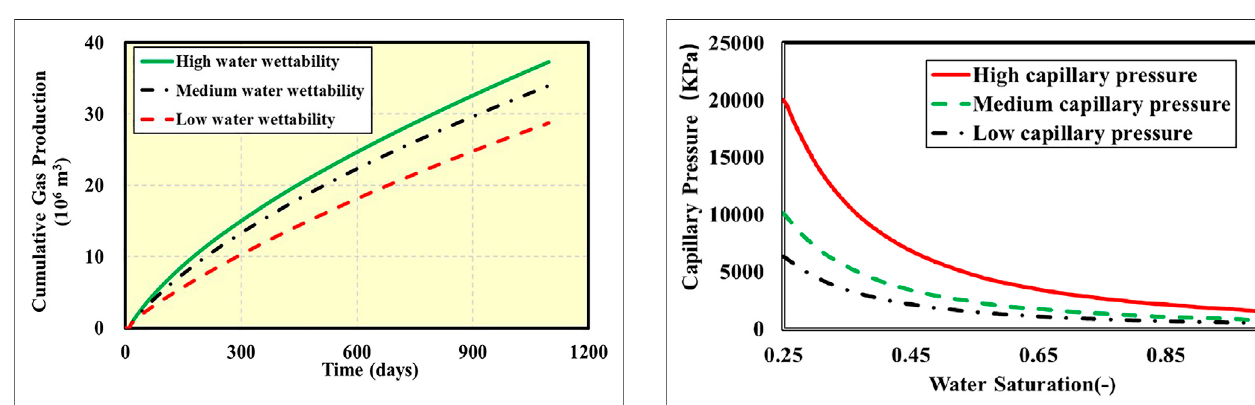
FIGURE 12 | Capillary pressure curves of the